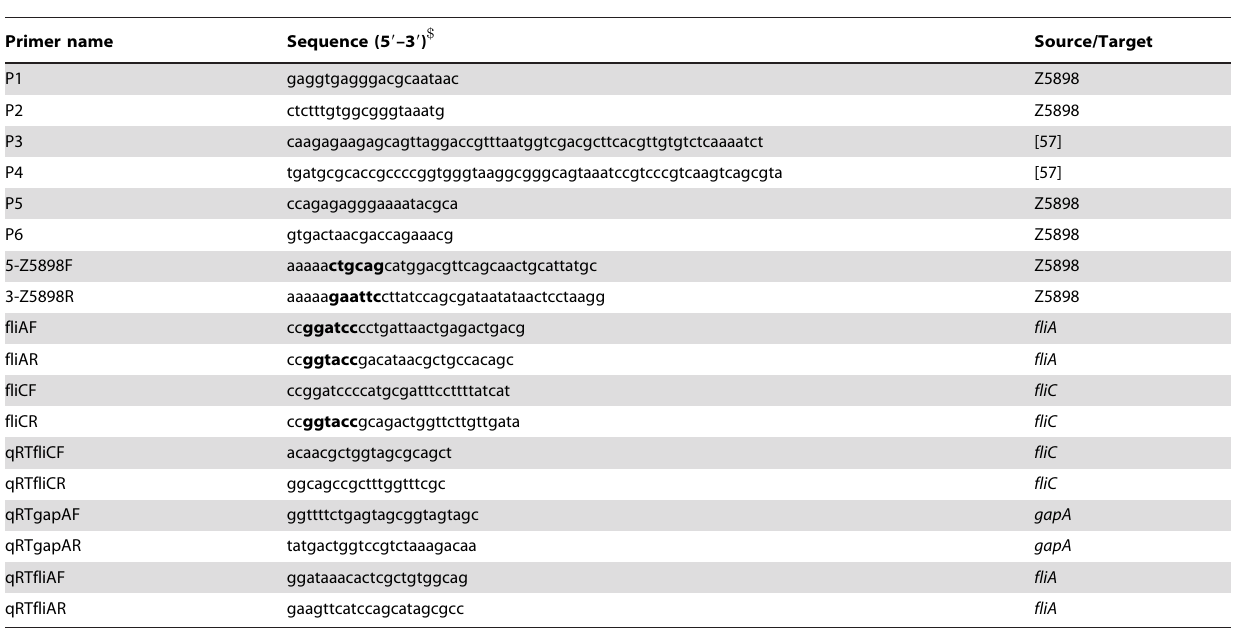
Table 2. Primers used in this